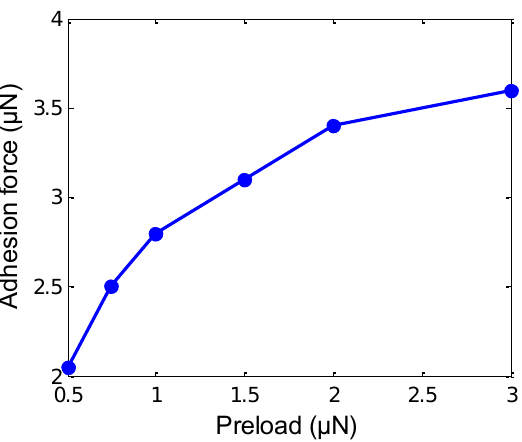
Figure 6. Results for the maximum pull-off force at different preload.